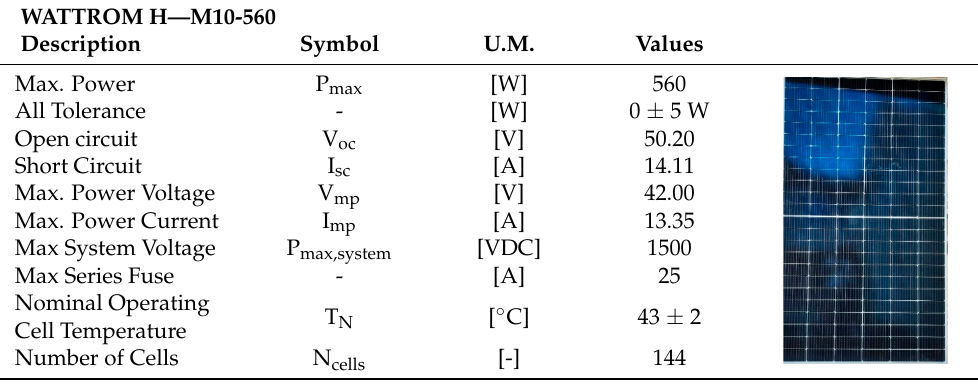
Figure 5. Plot representation of the temperature influence to the I SC characteristics of the PV gener- ator. Figure 6. Plot representation of the temperature influence to the V OC characteristics of the PV gen-